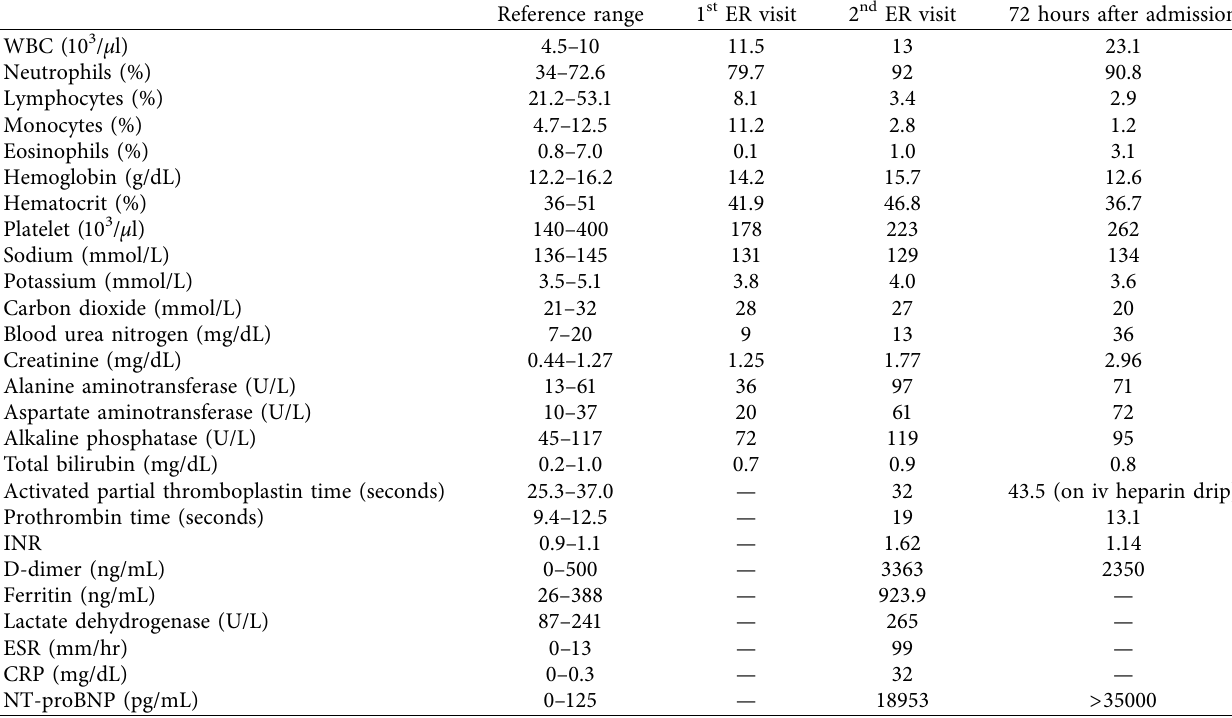
Table 1: Lab values for the patient on the two emergency room (ER) visits and during hospitalization.